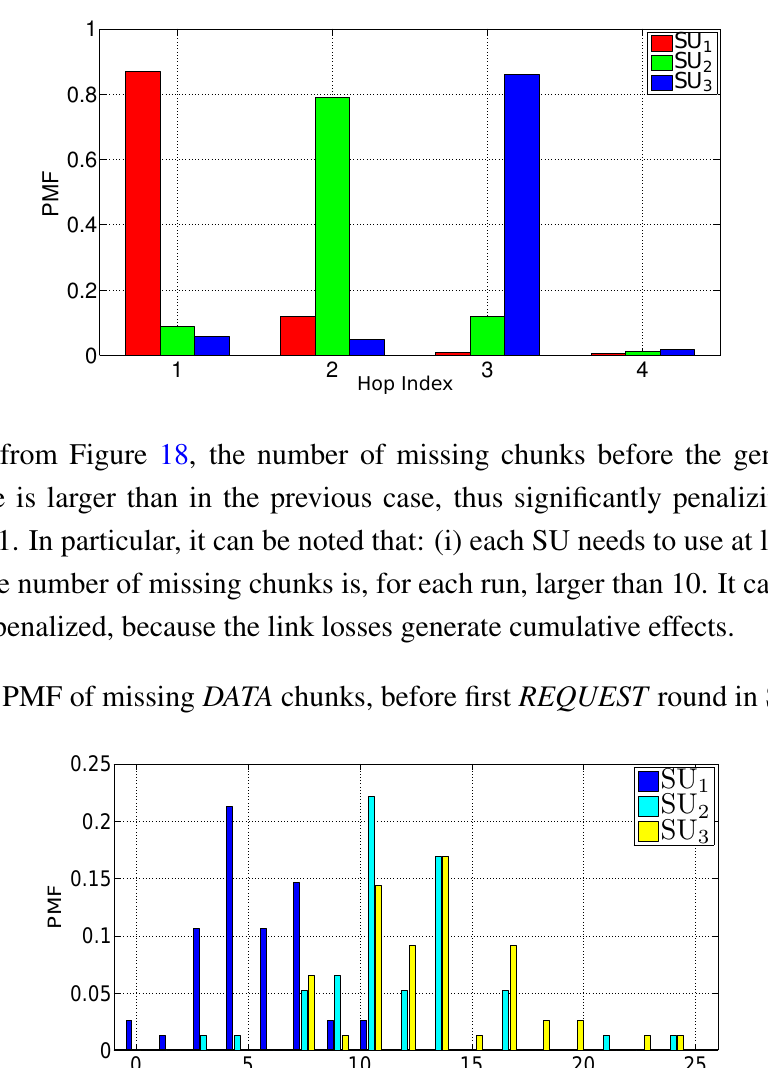
Figure 17. PMF of the hop index for received DATA messages in Scenario 2.